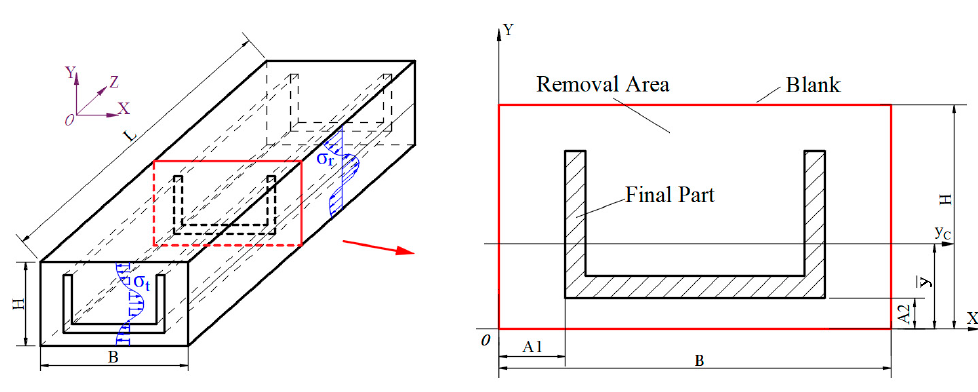
Figure 2. Schematic of machining distortion caused by initial residual stress.